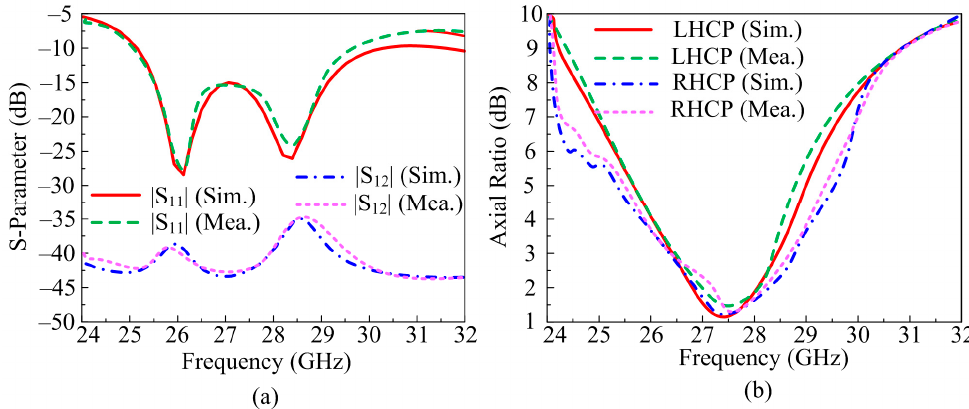
Figure 10. Comparison of results of MIMO antenna with parallel placement and inverted structure of element ( a ) scattering parameters ( b ) axial ratio.